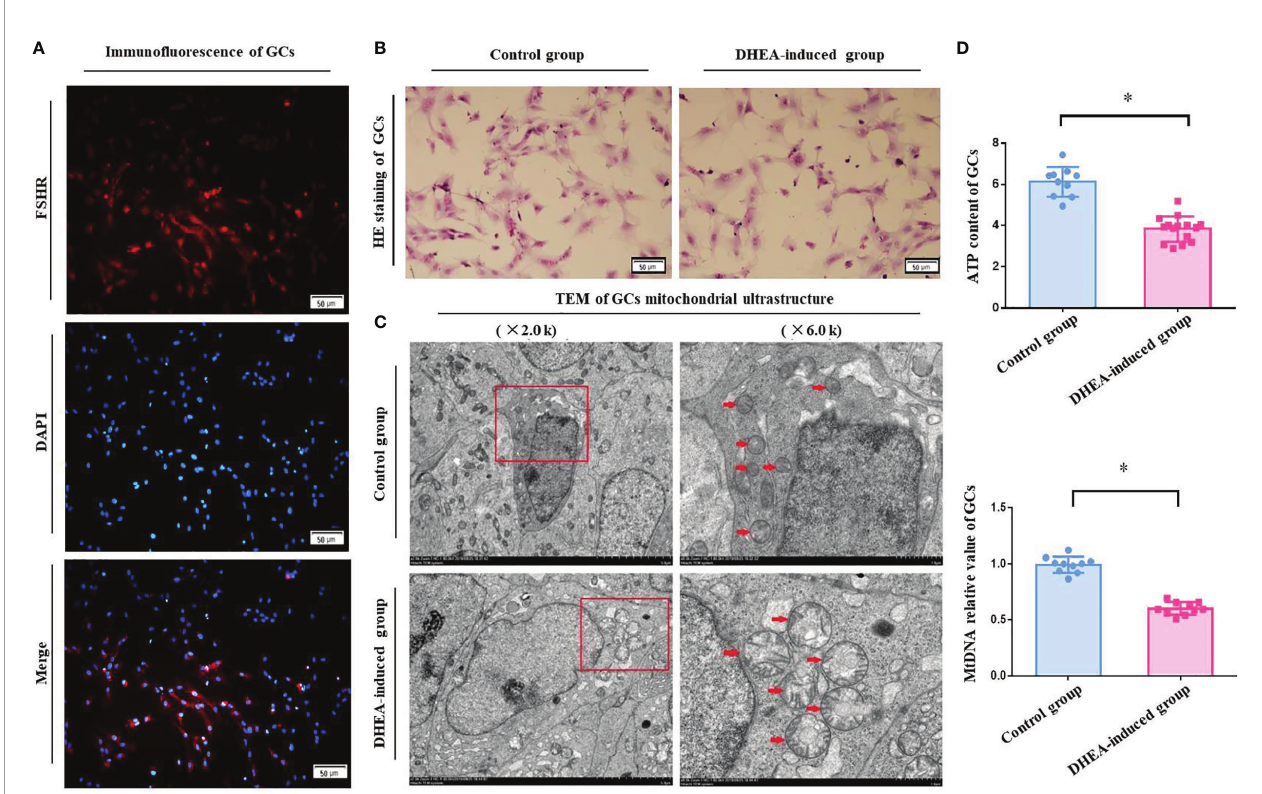
FIGURE 2 | (A) The speci fi c expression of FSHR in rat ovarian GCs was identi fi ed by immuno fl uorescence. The fl uorescent microscopy (Leica) results showed a speci fi c red fl uorescence in the cytoplasm of positive cells, blue fl uorescence in the nucleus of negative control cells and no red fl uorescence in the cytoplasm. Merge represents the fusion of two colored images. (B) Morphological observation of rat ovarian GCs stained with HE. HE staining coverslips showed that the rats ovarian GCs were intact with pink cytoplasm and red-purple round nuclei, and there were no obvious difference between two groups under light microscopy. (C) The mitochondrial ultrastructure of rat ovarian GCs were analyzed by TEM. As shown by the red arrow in the photos, GCs had a normal nucleus with a clear nucleoli and double nuclear membranes, and the mitochondria had a clear mitochondrial crista around the nucleus in control group. However, the ovarian GCs presented mitochondrial aggregated distribution, crista dissolution and fracture and mitochondria with vacuoles in PCOS model group rats. (D) The ATP content and mtDNA copy number of rat ovarian GCs were detected. According to the analysis, the ATP content (4.51 ± 0.49 m m) and the mtDNA copy number (0.58 ± 0.12) of the ovarian GCs in PCOS model group rats were signi fi cantly decreased compared with those in control group rats (ATP, 6.53 ± 0.41 m m; mtDNA , 1.00 ± 0.19). * P <